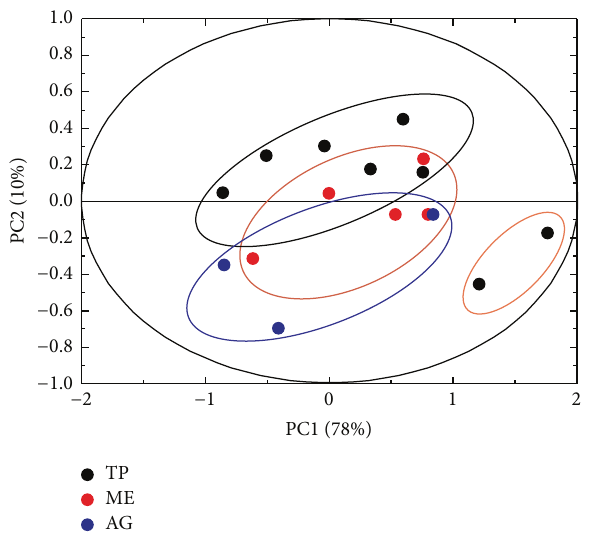
Figure 7: Score plot of the PCA analysis performed on Sicilian eVOOs samples. The results from different Sicilian regions are superimposed to each other; however the orange ellipse on the bottom right side refers to two Spanish cultivars grown in the province of Trapani: Arbosana and